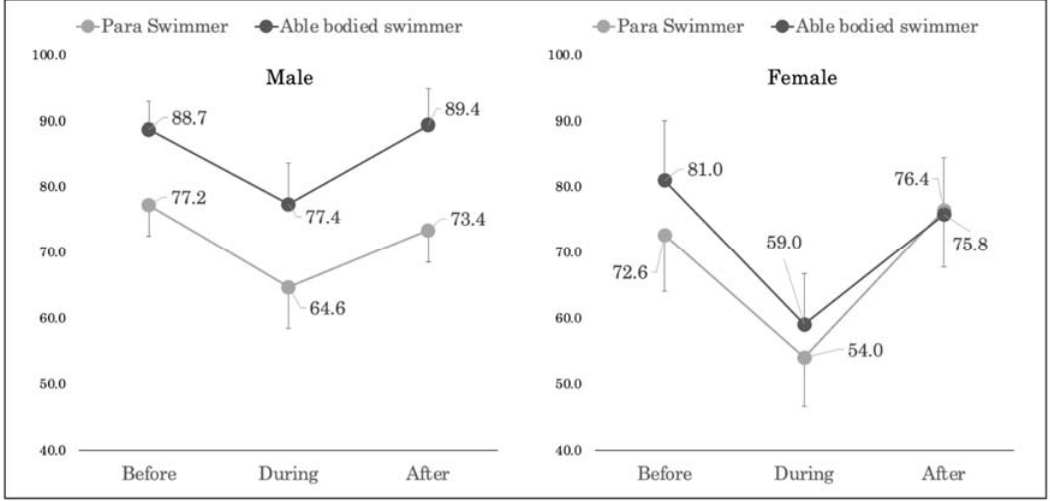
Figure 2. Comparison of LSA baseline, during, and follow-up the declaration of a state of emergency. Two-way ANOVA showed that there was no significant interaction between the male and female groups in the LSA. There was no significant main effect between groups in the female group, but there was a significant effect in the male group. The LAS during and at follow-up declaration within the male and female groups were analyzed using a two-way analysis of variance. A one-way analysis of variance was used as a post-hoc test, but no significant difference in time was observed. In the female group, there was no significant main effect between the groups or time, while in the male group, there was a significant main effect among the groups.